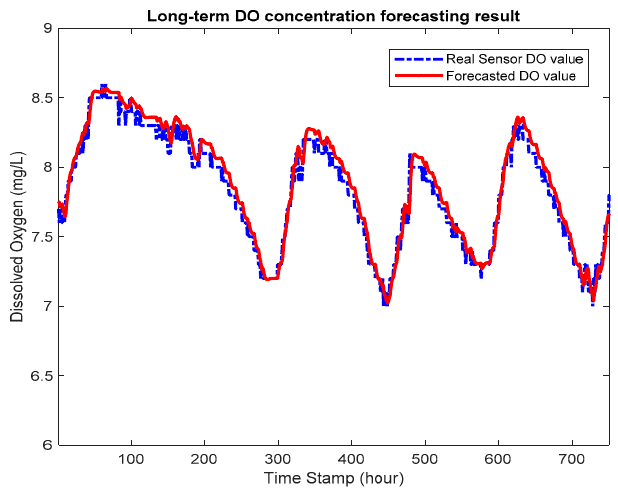
Figure 7. Short-term (12 h) forecast result measured against actual DO concentration values. Appl. Sci. 2020 , 10 , x FOR PEER REVIEW